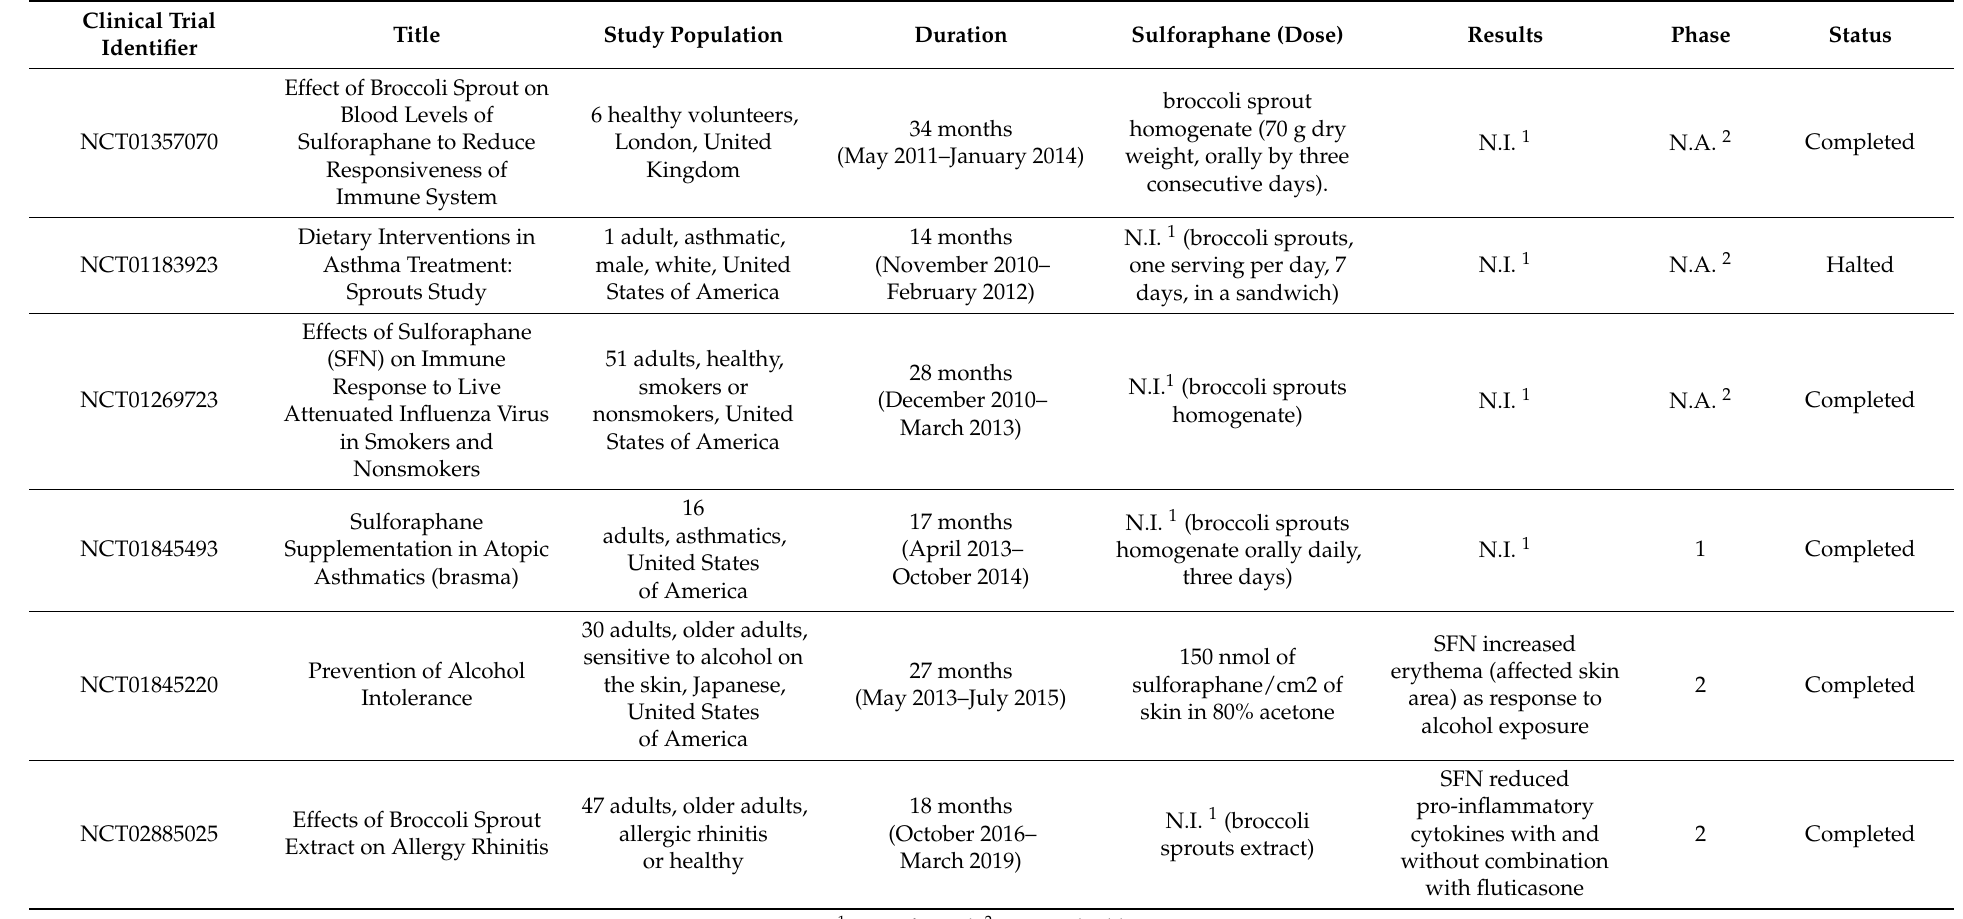
Table 1. Clinical trials regarding the effect of sulforaphane on immune system